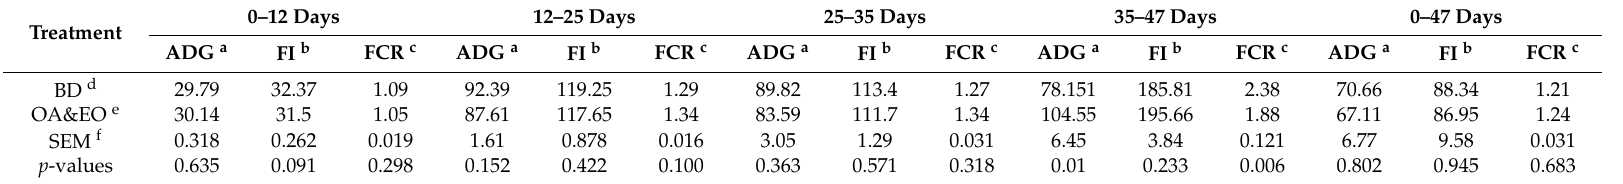
Table 2. E ff ects of dietary treatments on growth performance of broiler chicken (n = 90 for